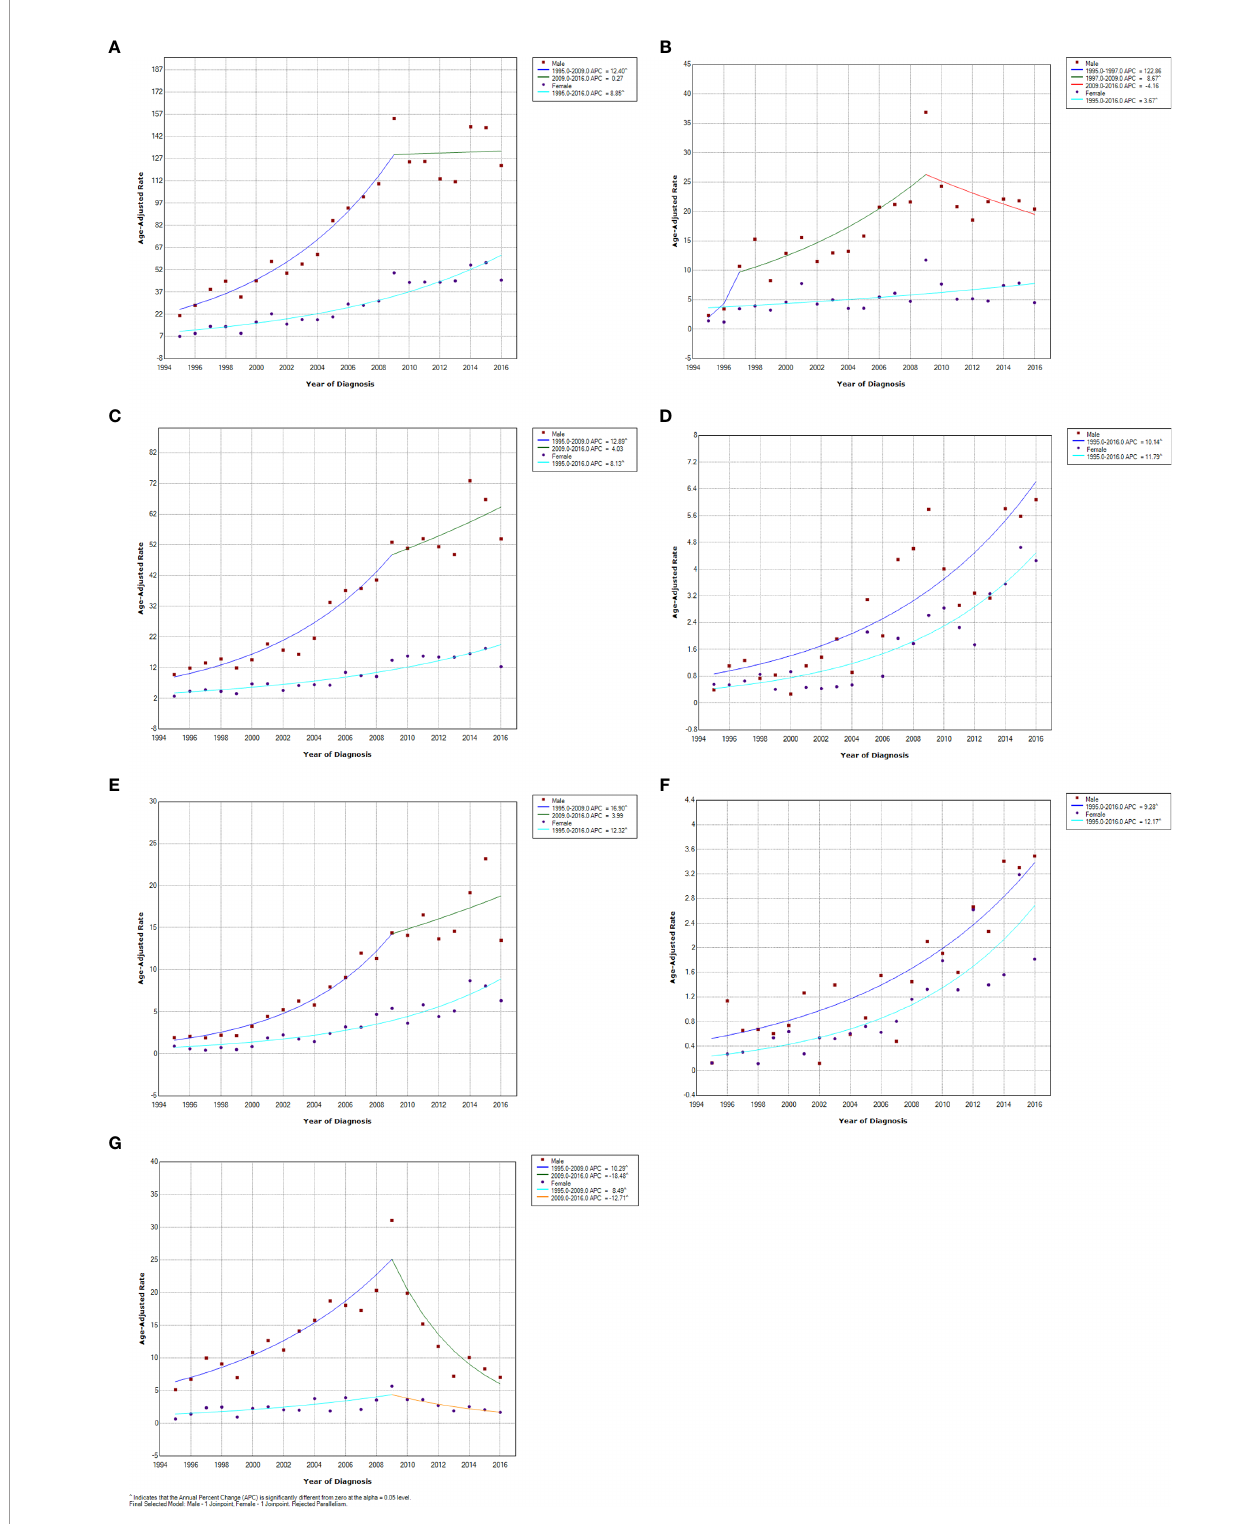
FIGURE 2 | Trend of annual percentage change for the age-adjusted standardized incidence rates of all gastrointestinal (GI) cancers and the common GI cancers strati fi ed by sex in Wuwei, northwestern China, 1995 – 2016. (A) all GI cancers, (B) Esophageal cancer, (C) Gastric cancer, (D) Colorectal cancer, (E) Liver cancer, (F) Pancreatic cancer, (G) Gastric cardia